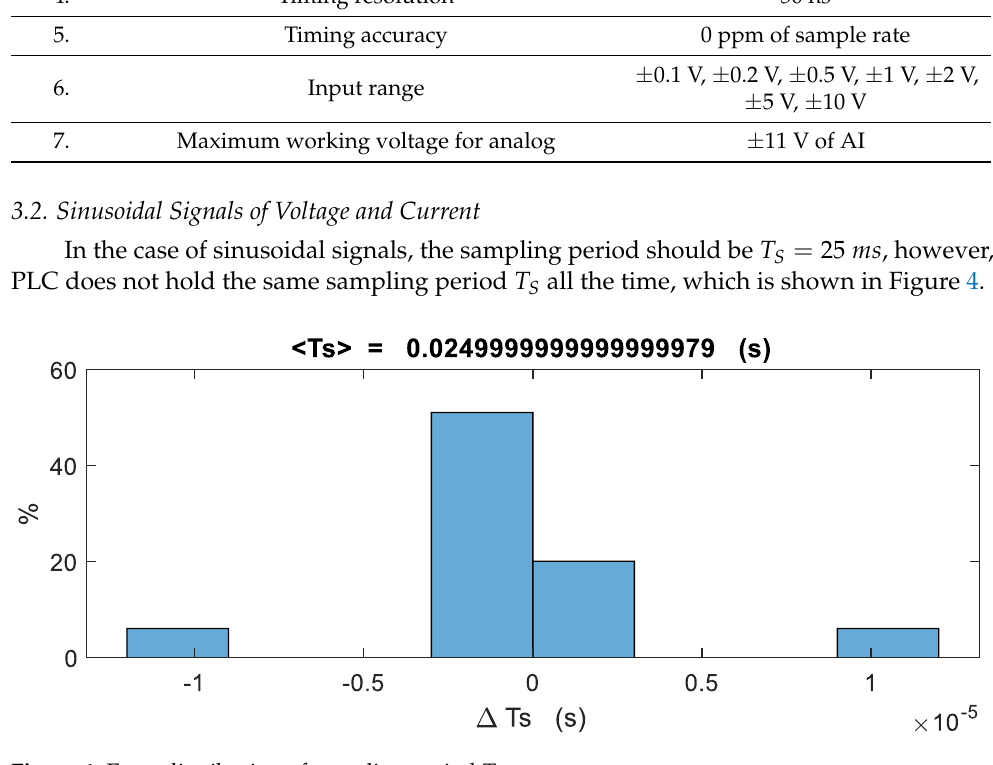
Figure 5. Samples of sinusoidal signals taken with card and PLC with average RMS values of cur- rent, voltage, and average values of power. The difference between two-point and four-point measurement methods of RMS val- ues are depicted in Figure 6.